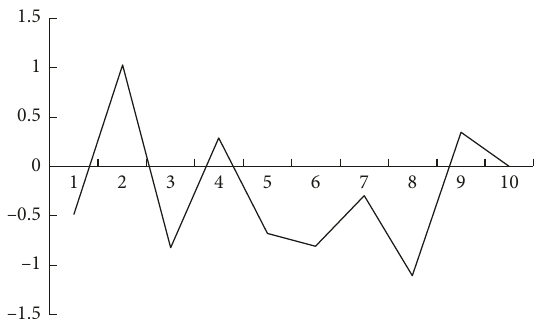
Figure 8: Grey phase spectrum of AQI and housing price.